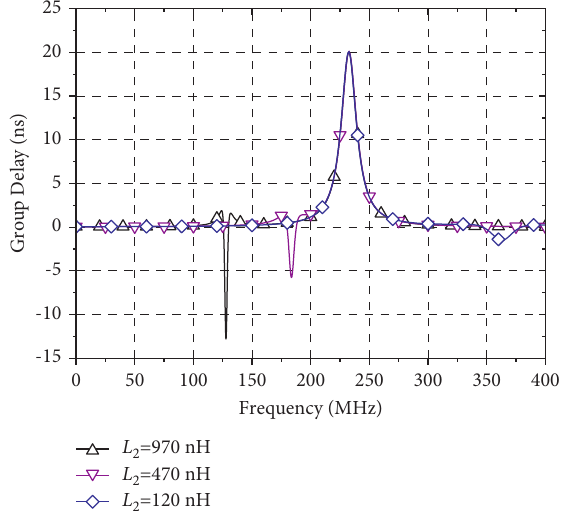
Figure 4: Negative delay of band pass in band-stop filter with different L 2 .